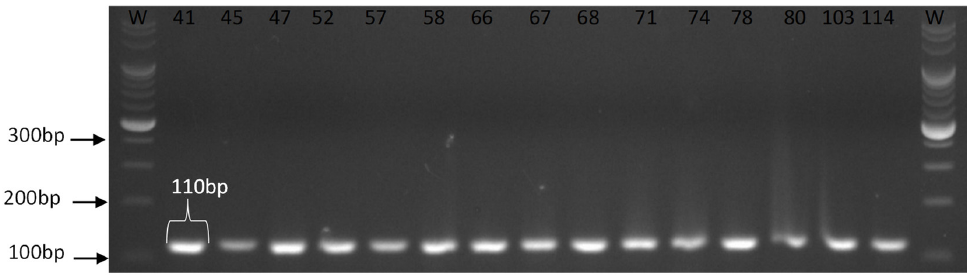
Figure 4. Electrophoretic image of PCR products in 2% agarose gel using umc2059 primer pair. All markers, except AD8, were associated with F. verticillioides resistance of the maize lines (Table 5). Percentage variance accounted for particular markers ranged from 0.7% (for bngl1621 170 bp and bngl1621 175 bp) to 19.9% (for STS03 (Table 5). The greatest genetic similarity (equal to 1) was found for lines 78 and 103, while the most diversity (equal to 0) for lines 28 and 258 (Figures 5 and Table 5. Characteristics of molecular markers associated with Fusarium verticillioides resistance.